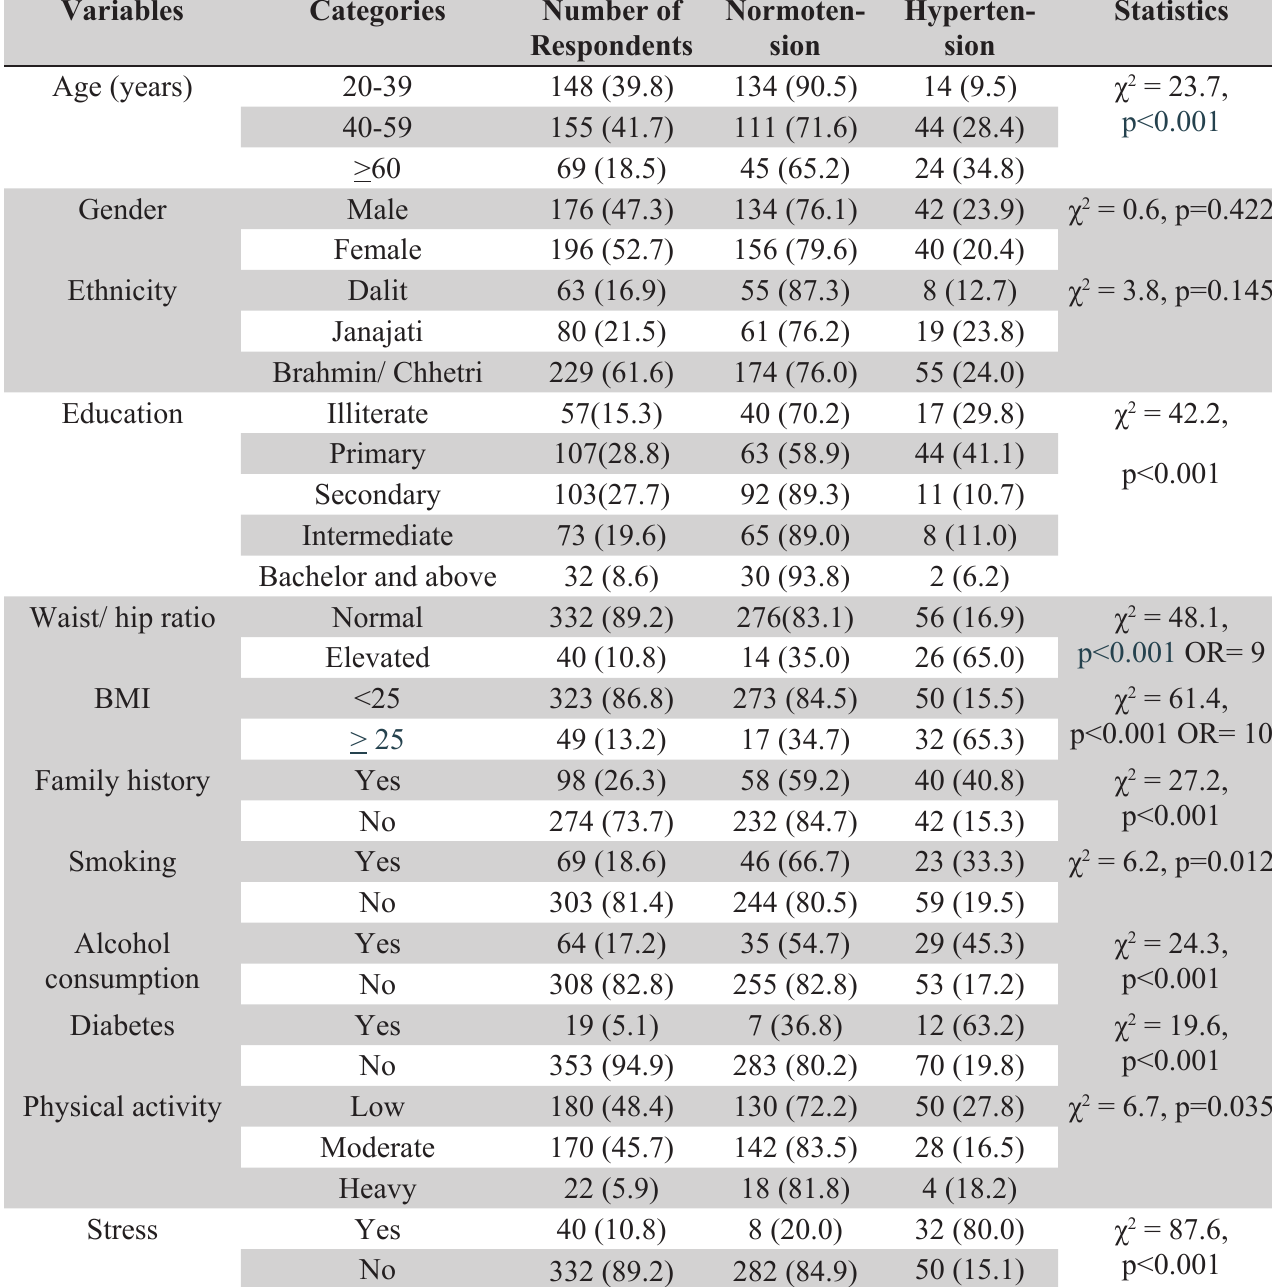
Table 2. Relation between blood pressure, demographic profile and other variables